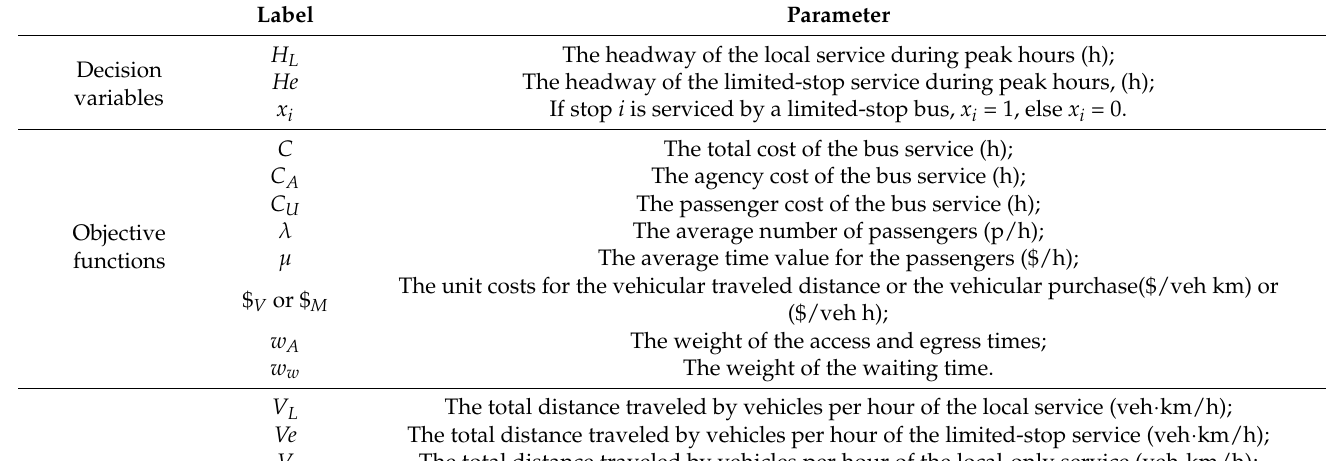
Table A1. The Meanings of